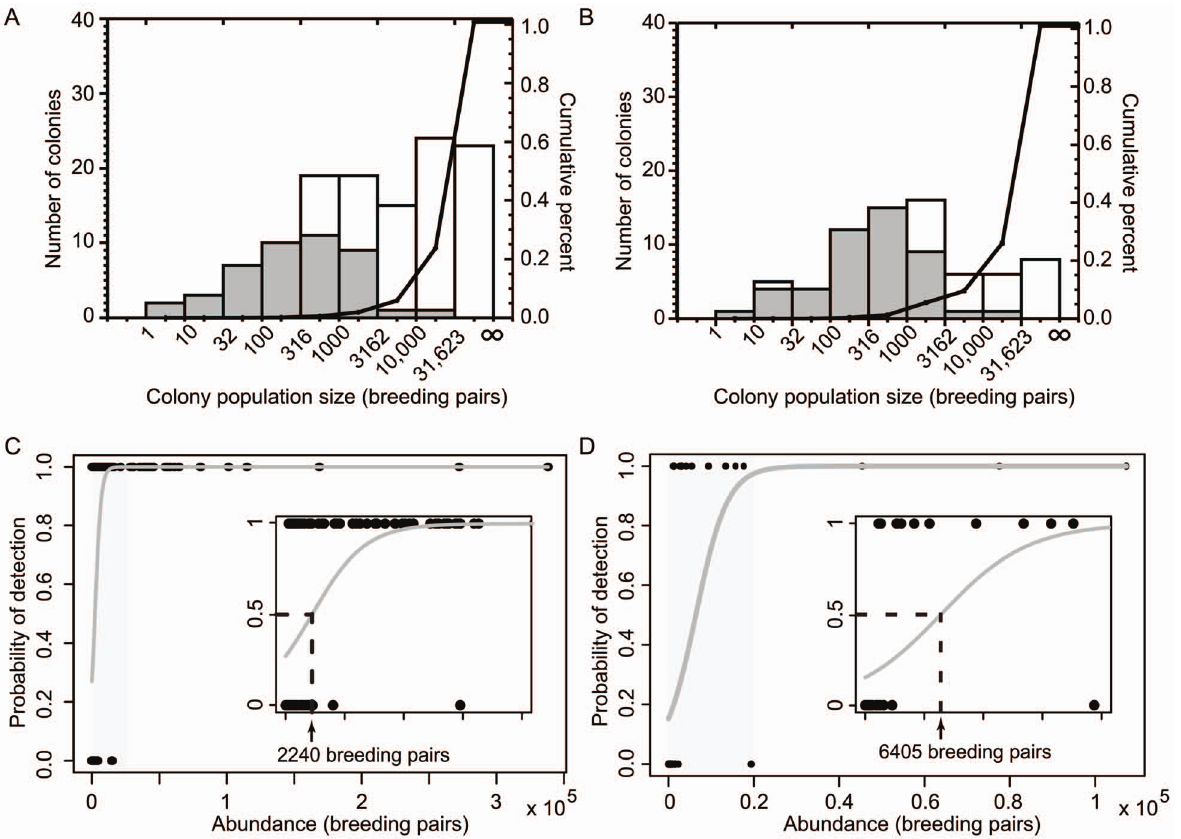
Figure 1. Probability of detection using Landsat-7 imagery. (A, B) The number of Ade´lie penguin colonies located (white) and missed (shaded) by the Landsat retrieval method for continental Antarctica (A) and the Antarctic Peninsula (B). The percent contribution of each bin to the total population is also illustrated. The horizontal axis is logarithmic, with boundaries equal to 10 0 , 10 1 , 10 1.5 , 10 2 , 10 2.5 , etc. (C, D) Probability of detection as a function of colony size (as reported by [5]) along the coast of continental Antarctica (C) and on the Antarctic Peninsula (D). Gray line represents best-fitting logistic model. Inset represents portion of the plot shaded in light gray.